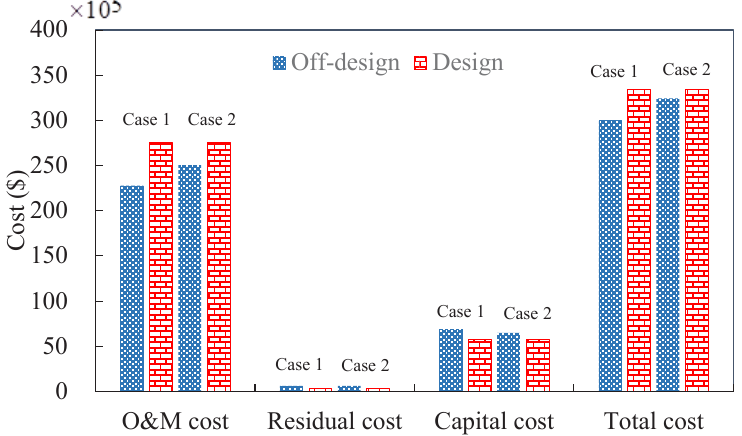
Figure 6. Cost comparison of detailed and simplified models for Case 1 and Case 2.